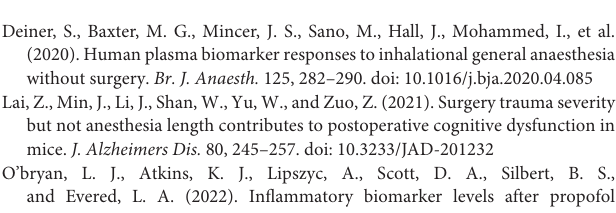
Supplementary Table 1 | The characteristics of the aged marmosets. Supplementary Video | The process of sevoflurane